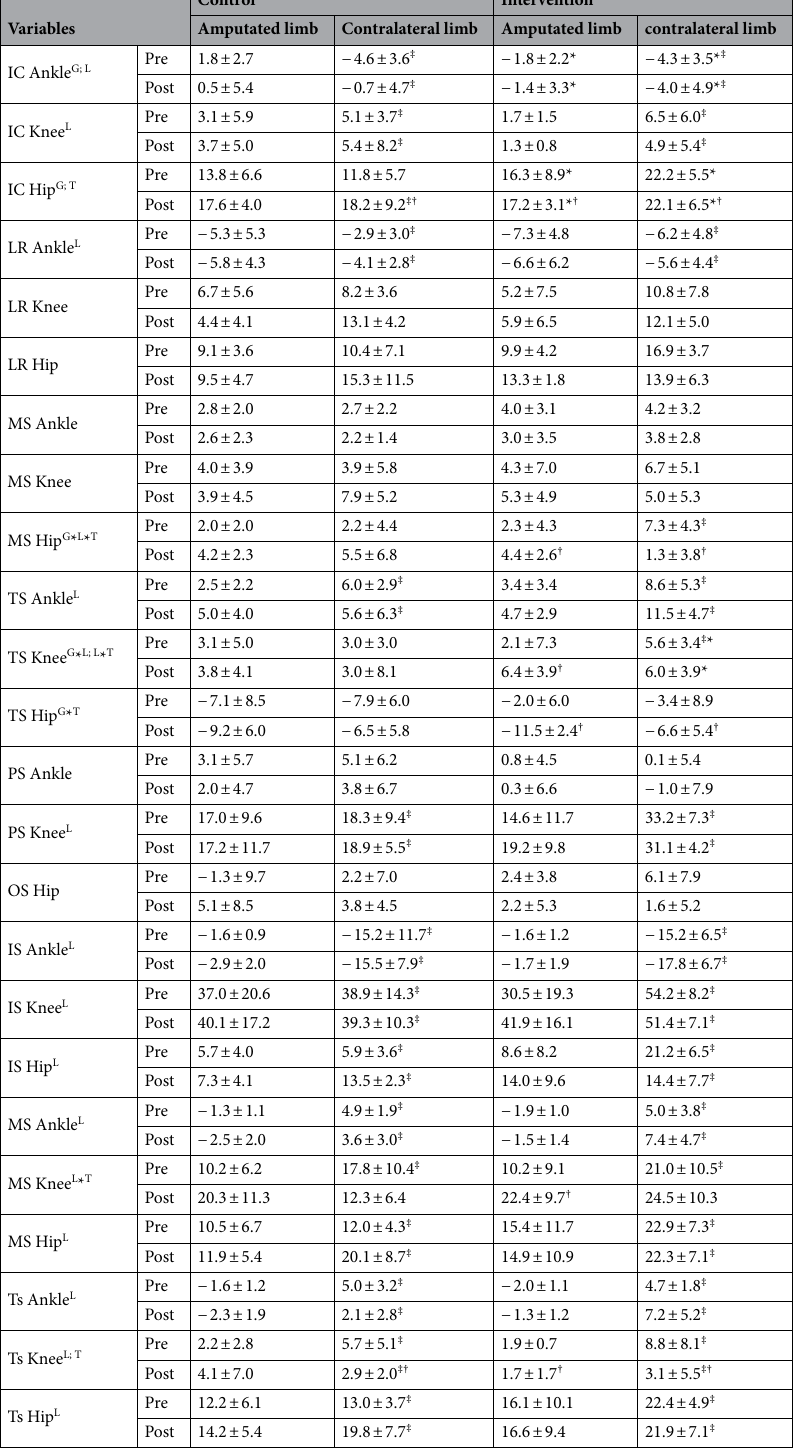
Table 3. Ankle, knee, and hip joint angles (º) in the sagittal plane during different phases of gait cycle, in amputees pre- and post-intervention. Phases of gait cycle are abbreviated as: IC (0–2% CG)—Initial